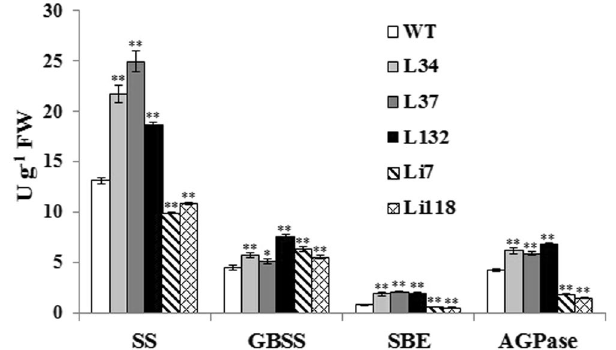
Figure 10. Enzyme activities of SS, GBSS, AGPase, SBE in the storage roots of the transgenic plants and WT. Data are presented as the mean ± SD (n = 3). * And ** Indicate a significant difference versus WT at P < 0.05 and < 0.01, respectively, based on Student’ s t